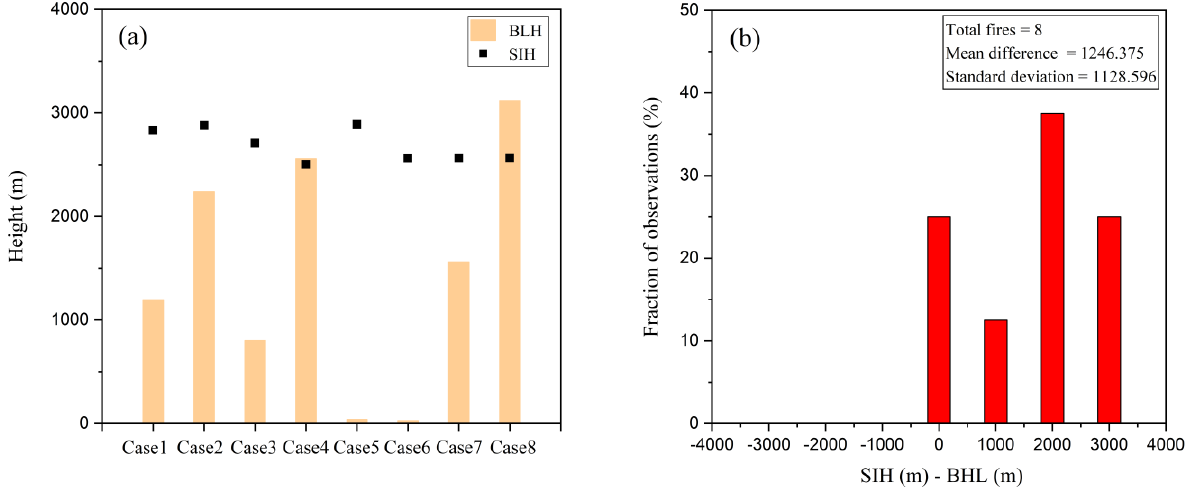
Figure 4. ( a ) Comparison of SIH and BLH. ( b ) Frequency distribution of the differences between SIH and BLH binned in 1000 m height intervals.